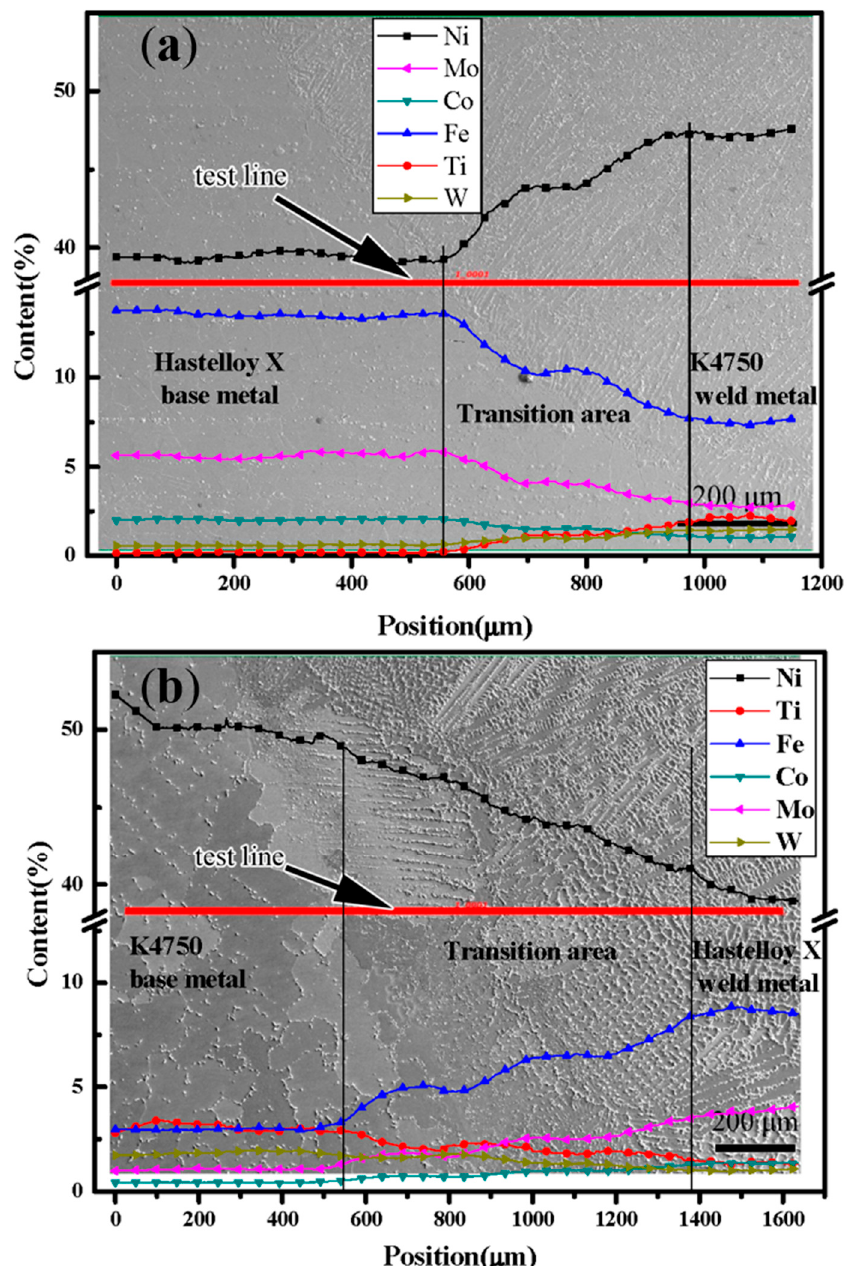
Figure 10. Elements distribution across the interfaces in dissimilar joints ( a ) interfacial element distribution in joints of K4750 filler material; and ( b ) interfacial element distribution in joints of Hastelloy X filler